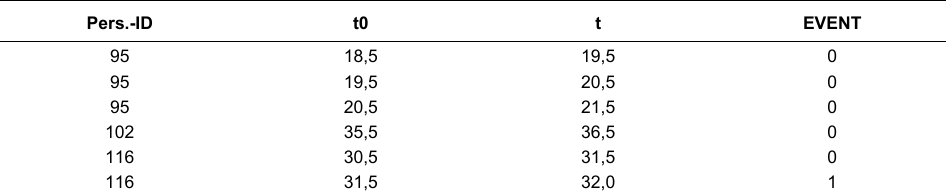
Tab. 3: Datensatz nach Korrektur der